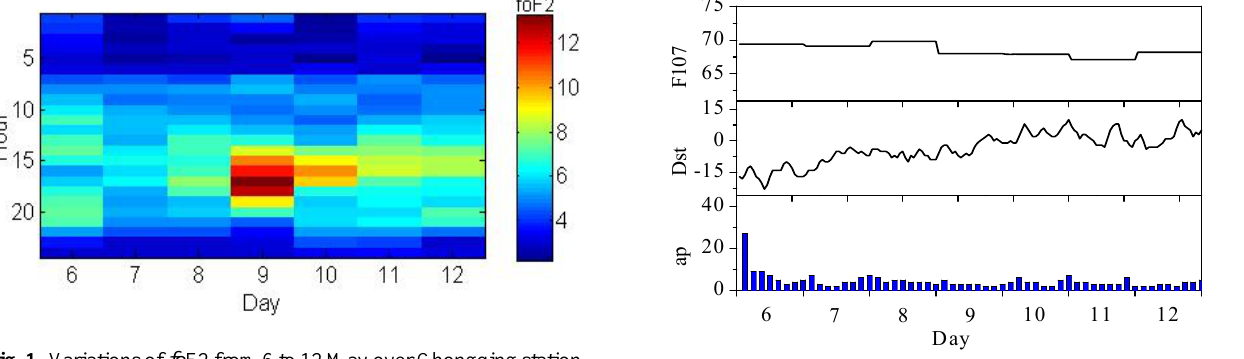
Fig. 2. Variations of F107, Dst and ap indices from May 6 to 12, 2008